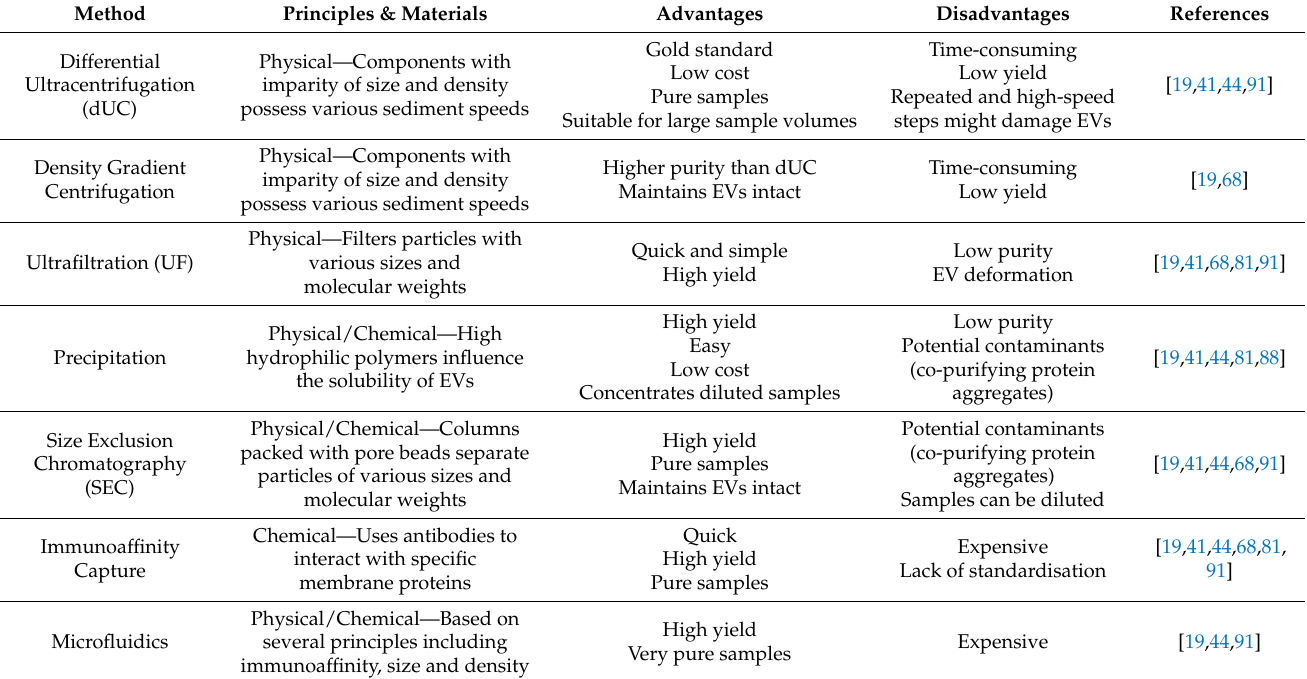
Table 2. Different methods of isolating EVs and their associated advantages and